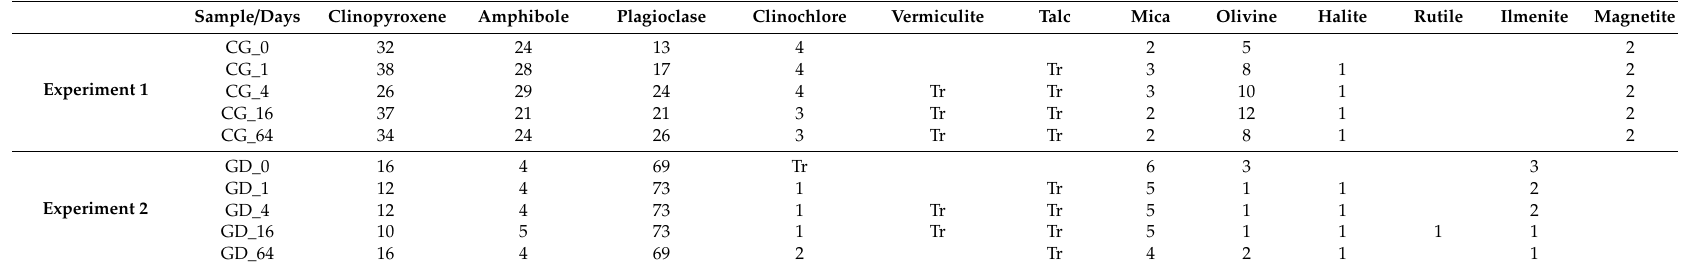
Table 4. Mineralogical composition obtained through powder XRD. Tr: trace